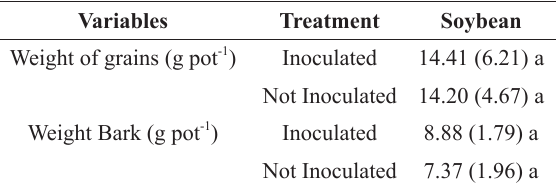
Soybean grain production of plants inoculated or uninoculated with the fungal solution composed of the fungi Beauveria bassiana, Metarhizium anisopliae, Pochonia chalamydosporia, Purpureocillium lilacinum, and Trichoderma asperella